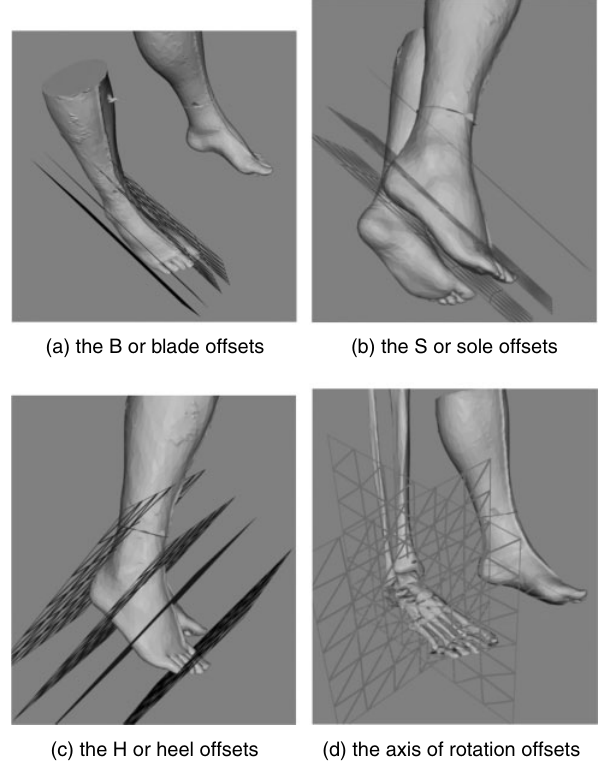
Figure 5 The parameterisation planes for the Visible Human male foot component: (a) the B or blade offsets, (b) the S or sole offsets, (c) the H or heel offsets, and (d) the axis of rotation